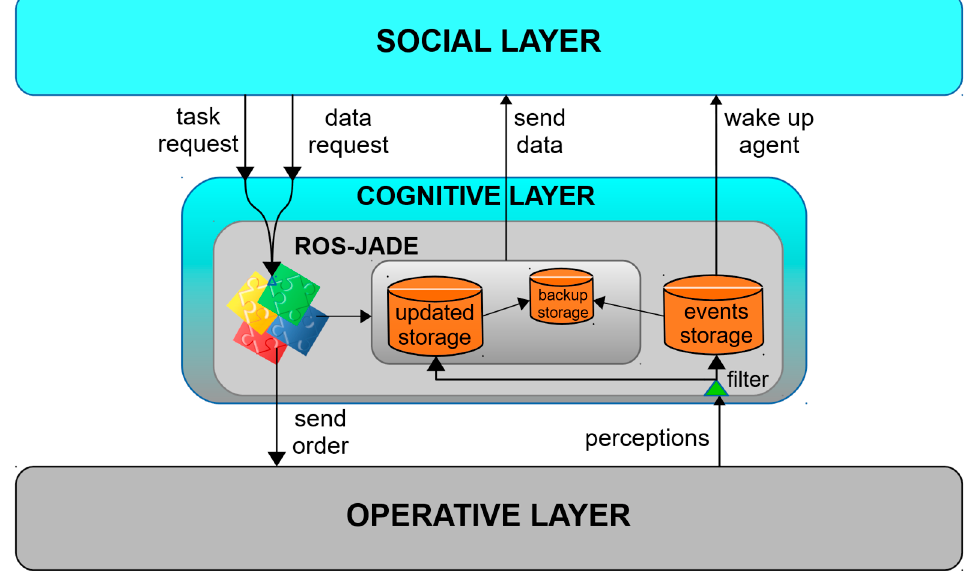
Figure 2. ROS-JADE component (cognitive layer).